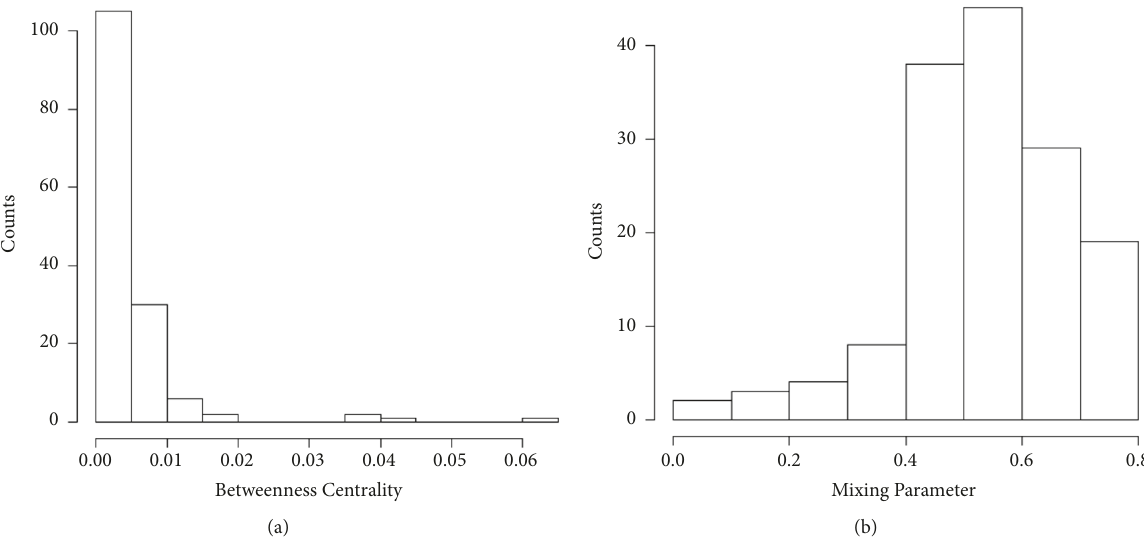
Figure 8: Histogram of (a) (normalized) Betweenness centrality and (b) mixing-parameter distribution of the PJM voting network. Table 9: Top fifteen voters in the PJM voting network based on node degree, betweenness centrality, and mixing parameter. The figures in the % column represent the frequency with which each voter voted with the consumer coalition on contentious rule changes in